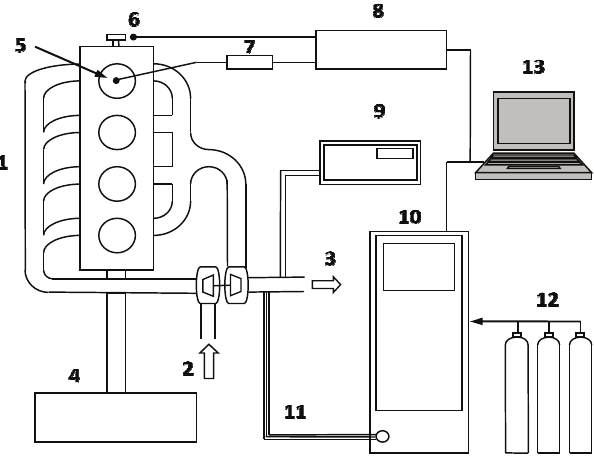
Fig. 1. Diagram of the test bench: 1 – engine PERKINS 1104C-E44T; 2 – air inlet; 3 – exhaust; 4 – brake; 5 – piezoelectric pressure sensor;